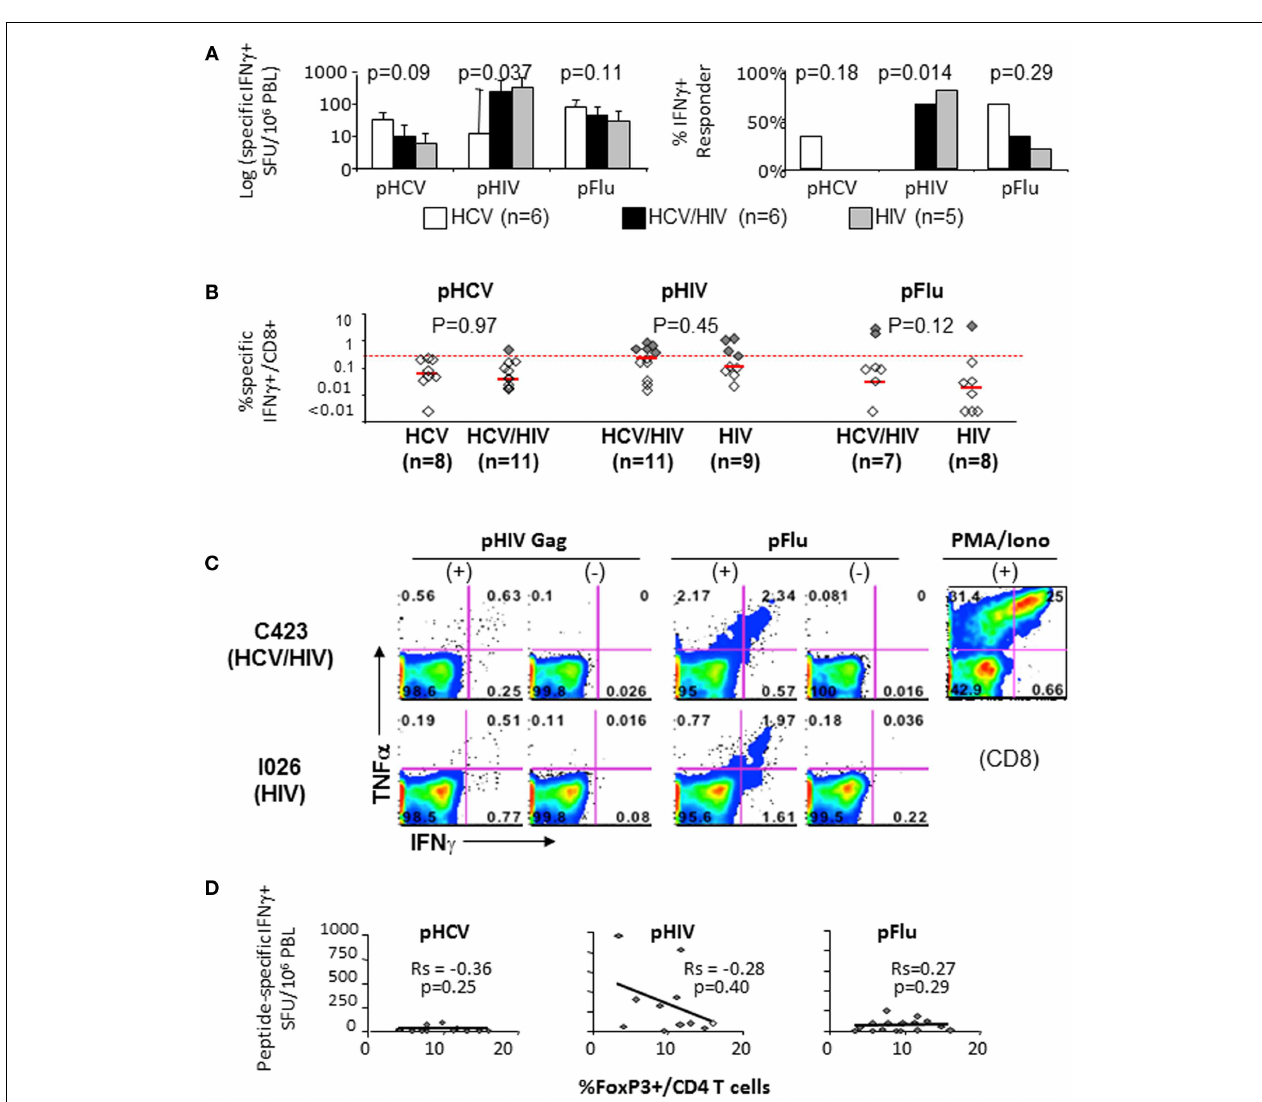
with overlapping peptide pools (2 µ M) and rIL-2 followed by further 5.5h peptide stimulation in the presence of Brefeldin A, intracellular cytokine staining, and FACS analysis.Total of 8 HCV/HIV-coinfected patients, 11 HCV-monoinfected, and 9 HIV-monoinfected patients were included, with sample size for each stimulation condition shown as defined by available lymphocytes. Red dotted line indicates the 0.27%, which was the cutoff value for a positive response based on average background + 3 SDs. Positive responses above 0.27% are further highlighted as dark shaded diamonds. P -values comparing two groups were calculated by non-parametric Mann–Whitney U without significant differences between the groups. (C) Representative FACS plots showTNF α and IFN γ expression in CD8-gated cells from an HCV/HIV-coinfected (C423) and HIV-monoinfected (I026) subjects. (D) Peptide-specific IFN γ response (in spot forming units per million PBMC) is compared with the frequency of FoxP3 + Tregs in CD4 T cell compartment from HCV/HIV-coinfected patients. Spearman rank-order correlation and P -values are shown without significant associations.